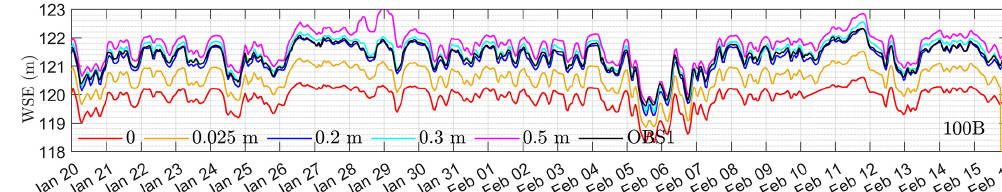
Figure A2. A comparison between observed WSE at 100B and modeled ones using different roughness heights.